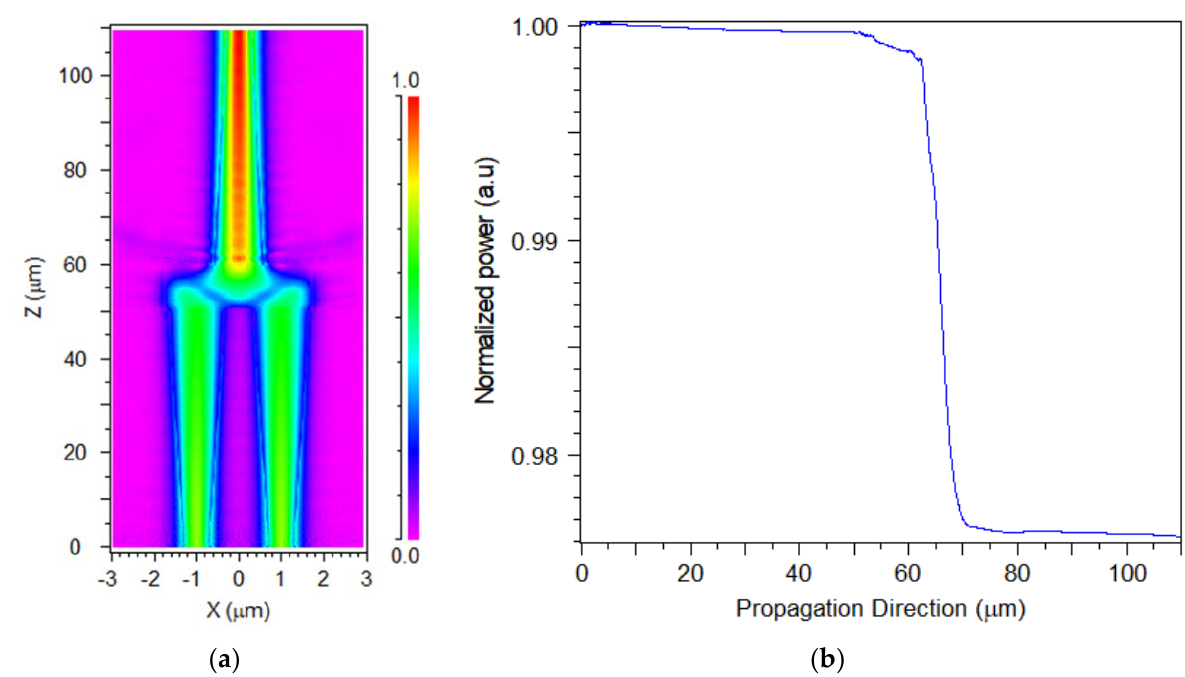
Figure 5. 2 × 1 combiner intensity light propagation profile under TE mode: ( a ) plane x-z; ( b ) z - axis.